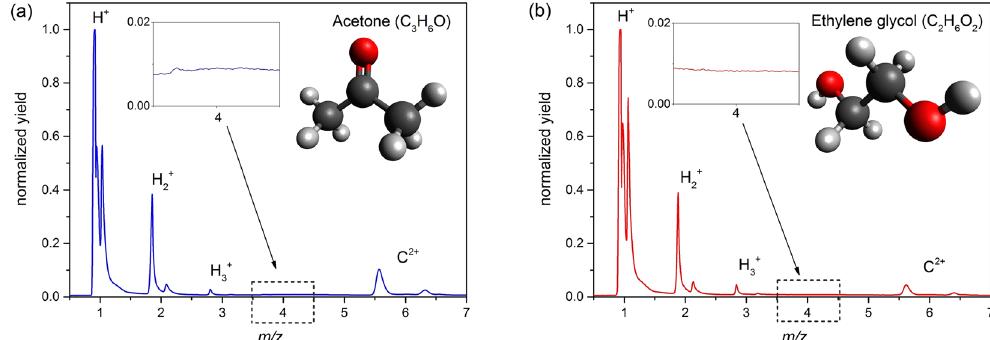
Figure 2. Truncated time-of-flight ion spectrum for ( a ) acetone and ( b ) ethylene glycol in a linearly polarized laser focus of 2.5 × 10 14 W/cm 2 under identical experimental conditions. Only ions relevant to this discussion (i.e. with a mass-to-charge ratio m/z < 7) are shown. Each yield is normalized with respect to the peak value of the corresponding H + yield. Note that in both spectra, no C 3 + at m/z = 4 was observed (see corresponding inset). The higher yield for forward (early time) ion signals is caused by an extraction slit as explained in the Methods: Experimental Setup section.